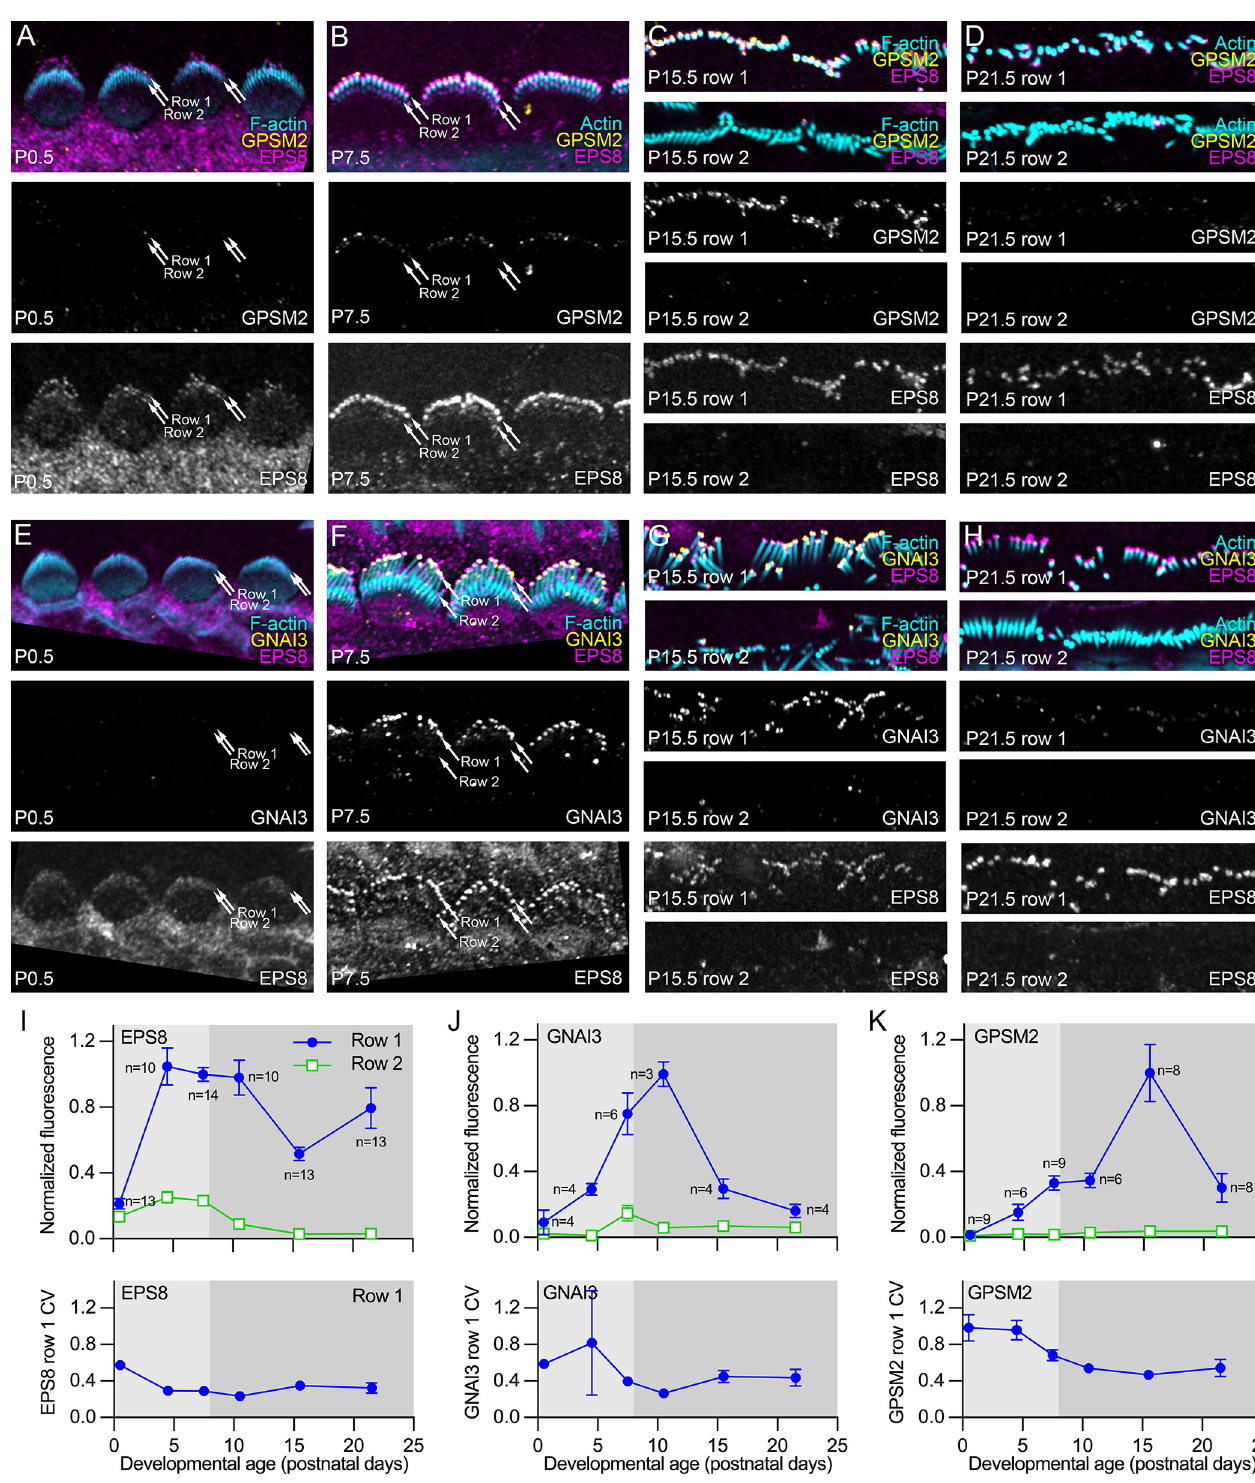
Fig 9. Developmental expression of row 1 complex proteins in IHC stereocilia. ( A–D ) Localization of GPSM2 and EPS8 in P0.5, P7.5, P15.5, and P21.5 IHCs. ( E, F ) Localization of GNAI3 and EPS8 in P0.5, P7.5, P15.5, and P21.5 IHCs. In (A, B) and (E, F), images are projections of horizontal slices with partially flattened hair bundles. In (C, D) and (G, H), images are projections of horizontal slices obtained at the level of row 1 tips only (top) or row 2 tips and row shafts (bottom). Images in A–D were acquired in the same imaging session and used the same acquisition, processing, and display parameters; the same holds for images in E–H. Arrows in A–F indicate level of rows 1 and 2. Panel widths: A–H, 30 μ m. ( I-K ) Quantitation of EPS8, GNAI3, and